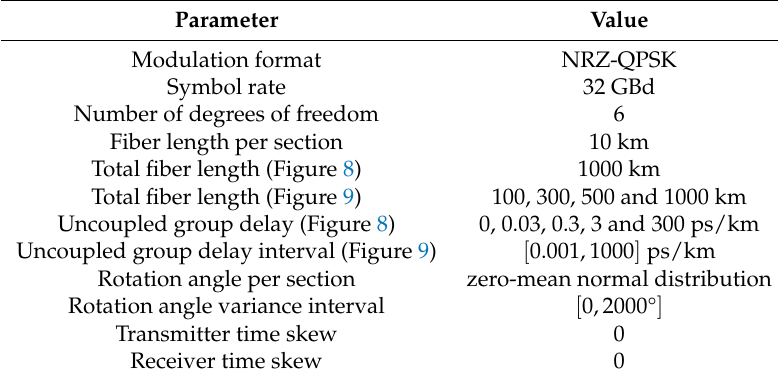
Table 3. Parameters for evaluation of CTA due to PMD in single-mode fiber transmission.